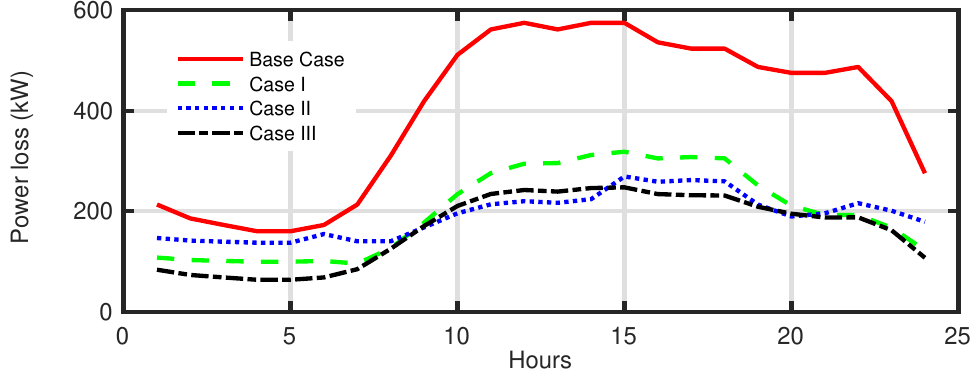
Figure 4. Hourly active power demand profile 33-bus test distribution system.